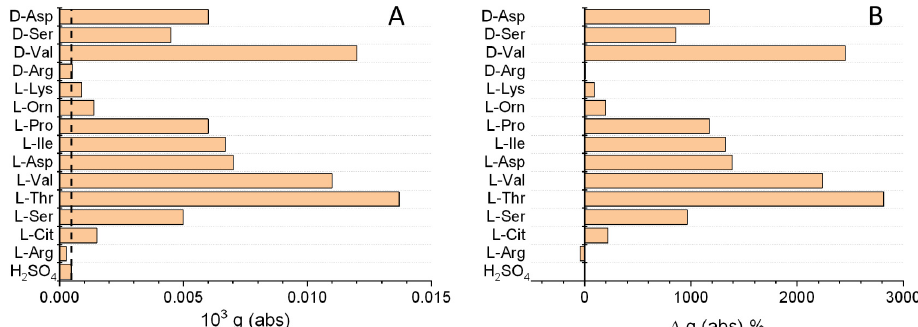
Figure 5. Bar graph of ( A ) the absolute values for the dissymmetry g -factor measured at the J-band for J-aggregates of TPPS 4 in the presence of the various amino acids (the dashed black line mark the reference value obtained for the spontaneous symmetry breaking induced in the presence of H 2 SO 4 only); ( B ) the percent deviation of g -factor values with respect to the reference sample.